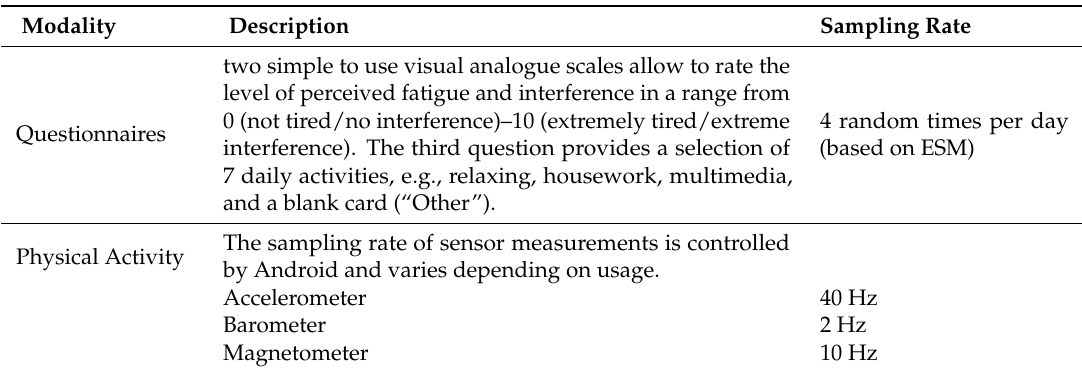
Table 1. Data collected by the